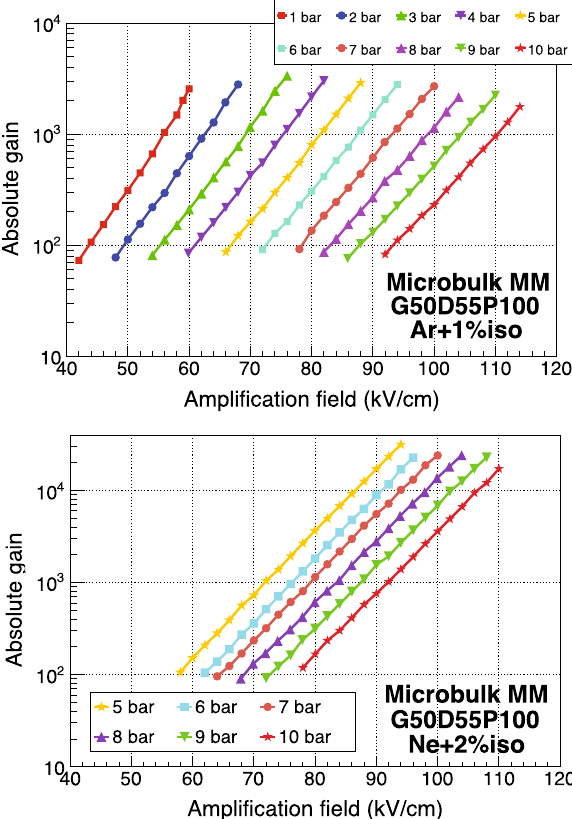
Fig. 4 Gain curves obtained in the characterization of microbulk Micromegas with Ar (top) and Ne (bottom) mixtures using a 109 Cd source. Curves for different pressures up to 10 bar are shown